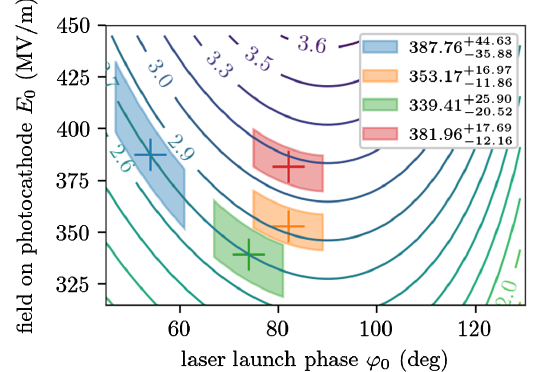
FIG. 4. Simulated kinetic-energy isoclines as a function of rf-gun operating conditions K ð E 0 ; φ 0 Þ and retrieved operating points ( “ þ ” symbols) for four measurements. The labeled isoclines give the kinetic energy in MeV units. The shaded areas represent the uncertainty on the measured φ 0 and inferred E 0 values (reported in the legend in MV = m units).